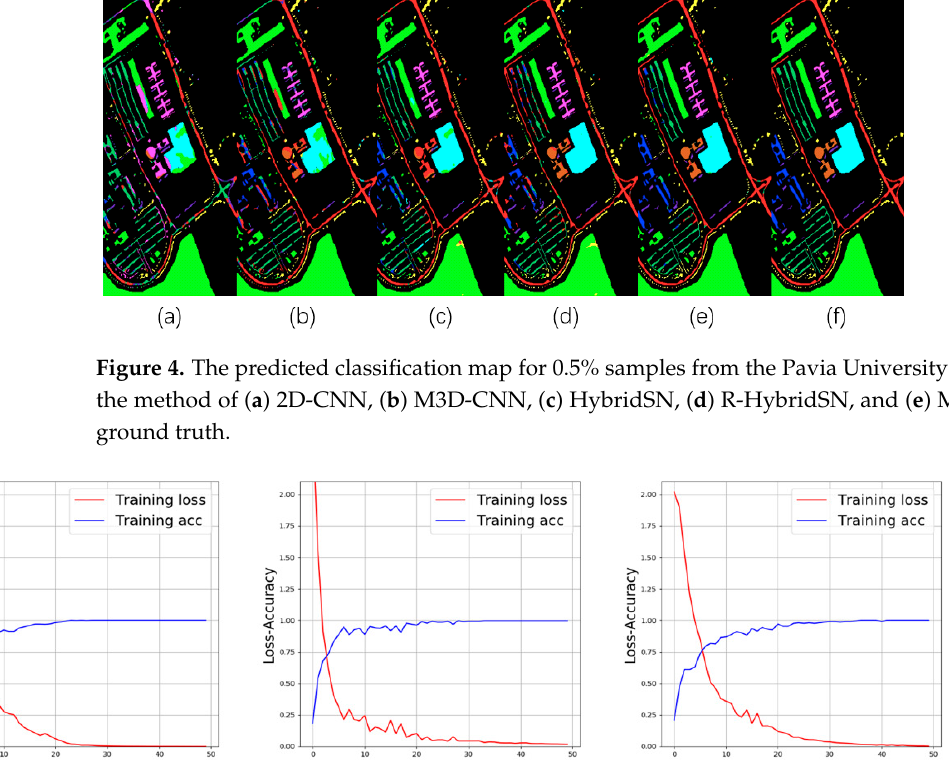
91.53 Table 3. Accuracy comparison of different methods for 0.5% samples of Salinas. Order